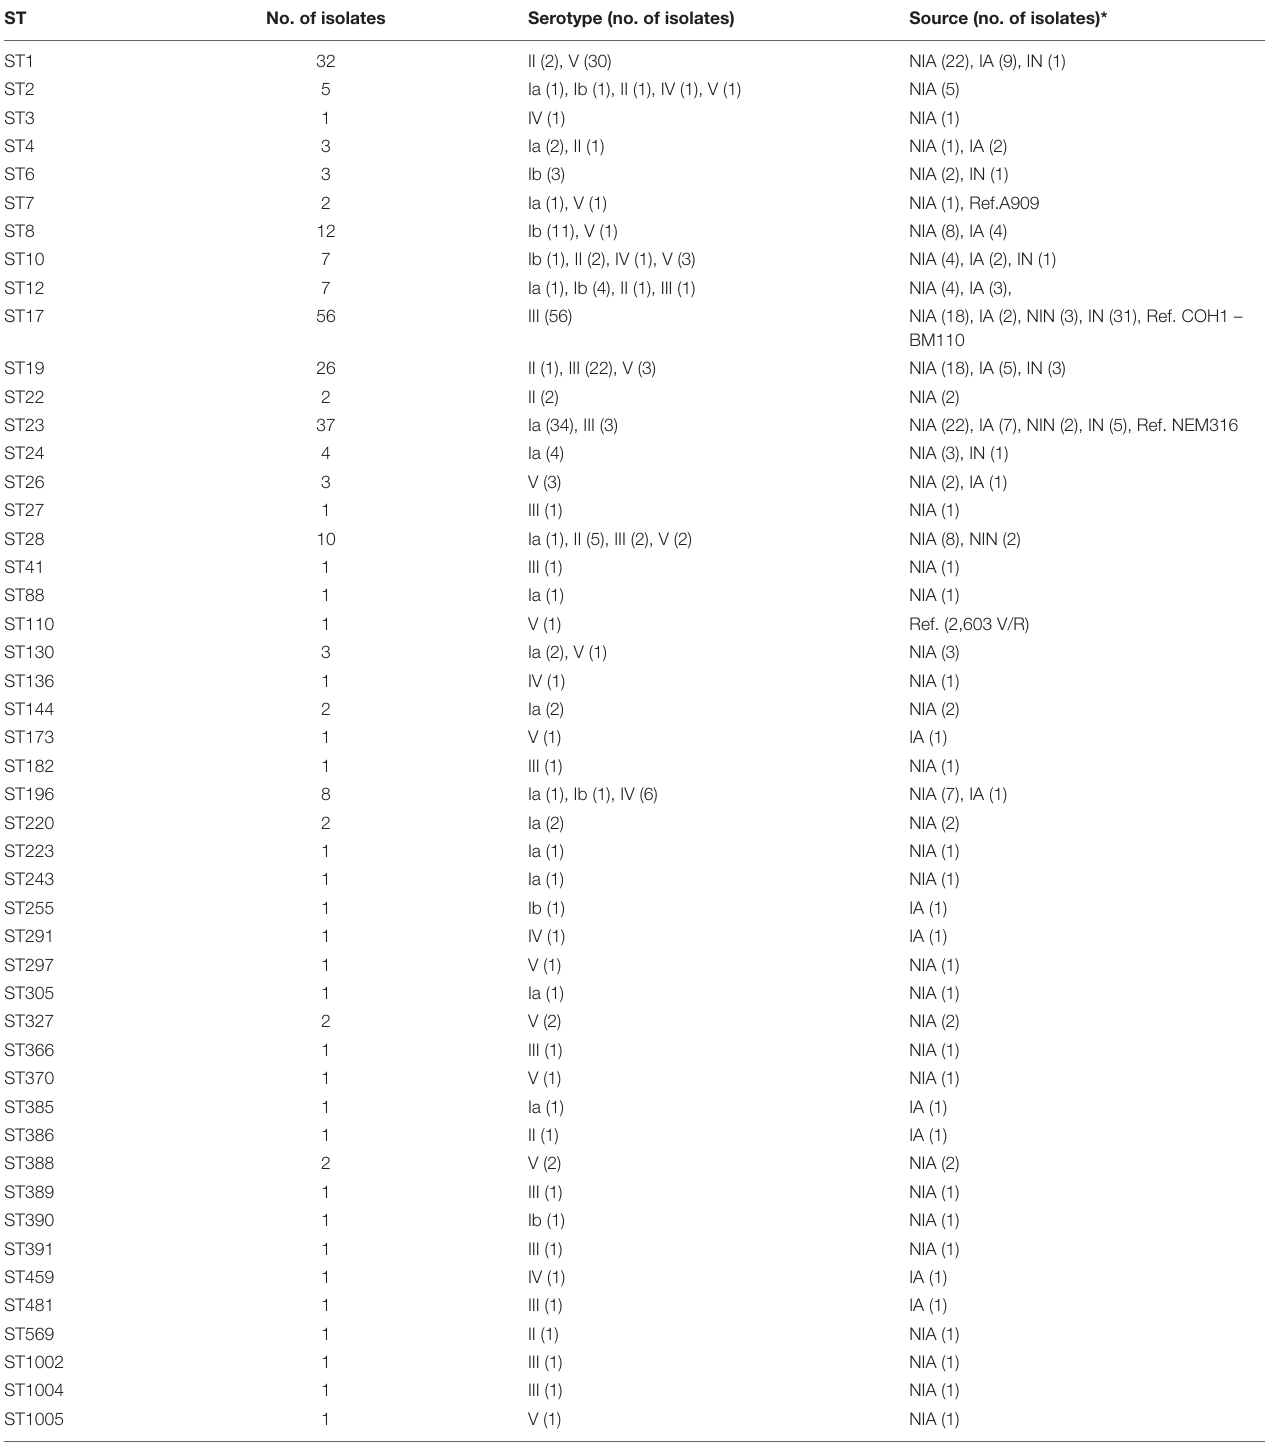
TABLE 1 | Characteristics of the 255 GBS isolates tested classified by sequence type. ST No. of isolates Serotype (no. of